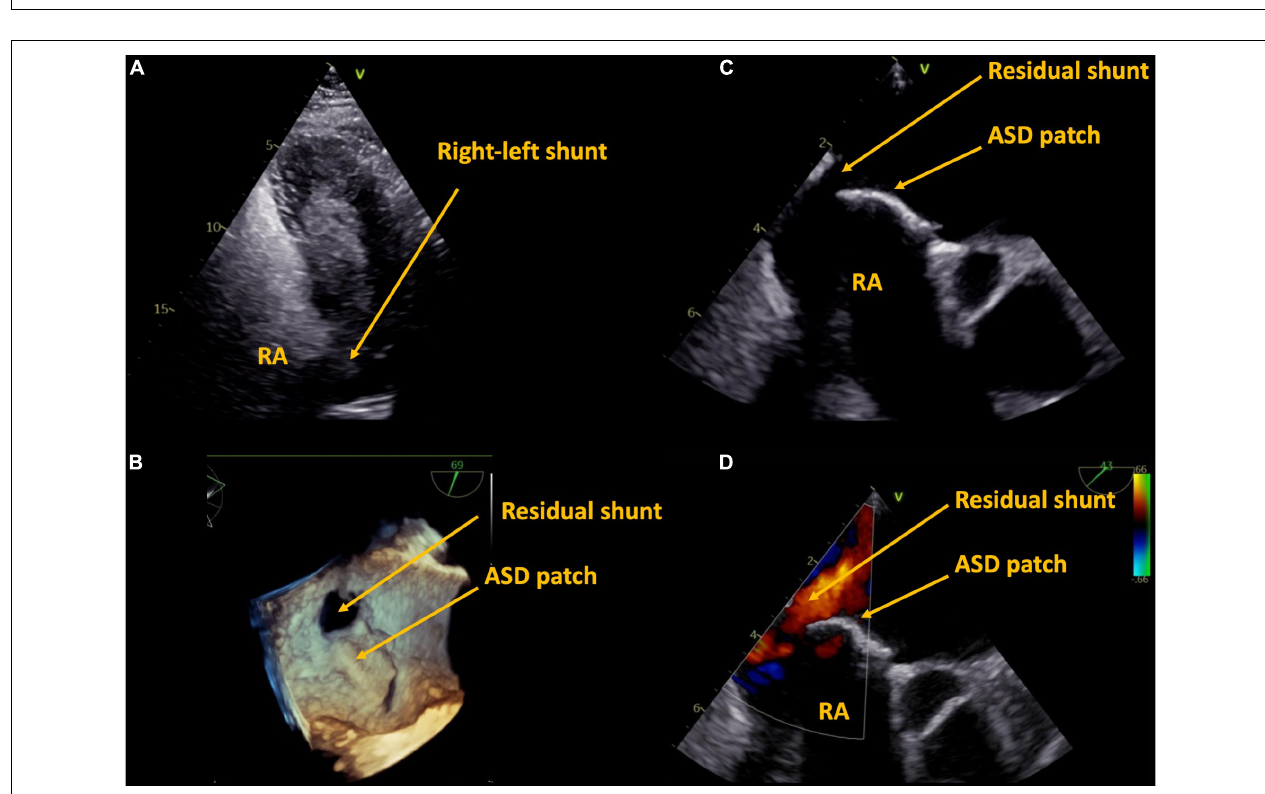
FIGURE 1 | Timeline depicting the medical history of both presented patients. ASD, atrial septum defect.